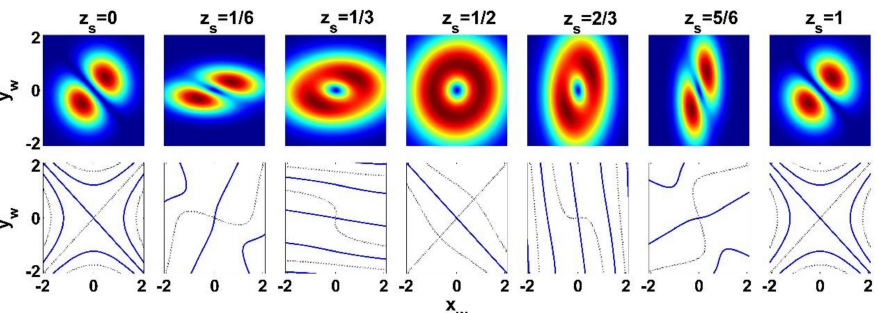
Figure 5. Same as Figure 4 but for β x = β y = 1/3, z p = R 0x = − R 0y = z R .